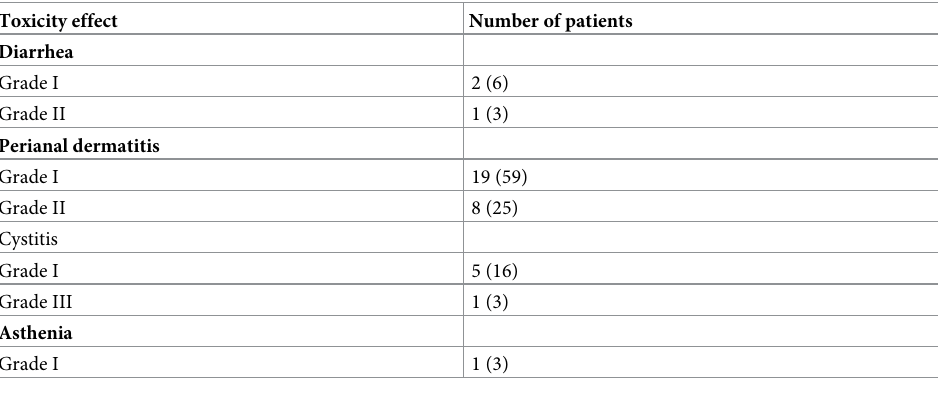
Table 2. Early toxicity effects of neoadjuvant radiochemotherapy.